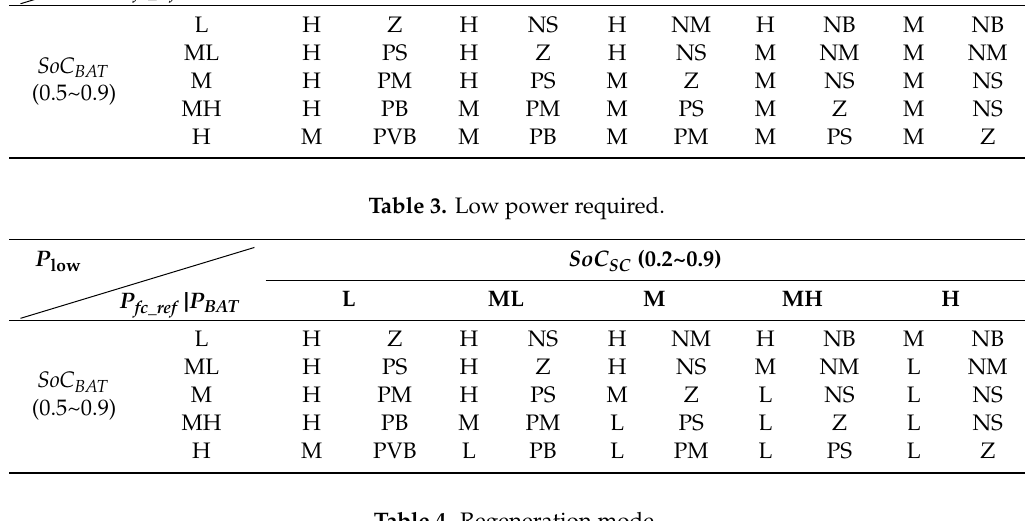
Table 4. Regeneration